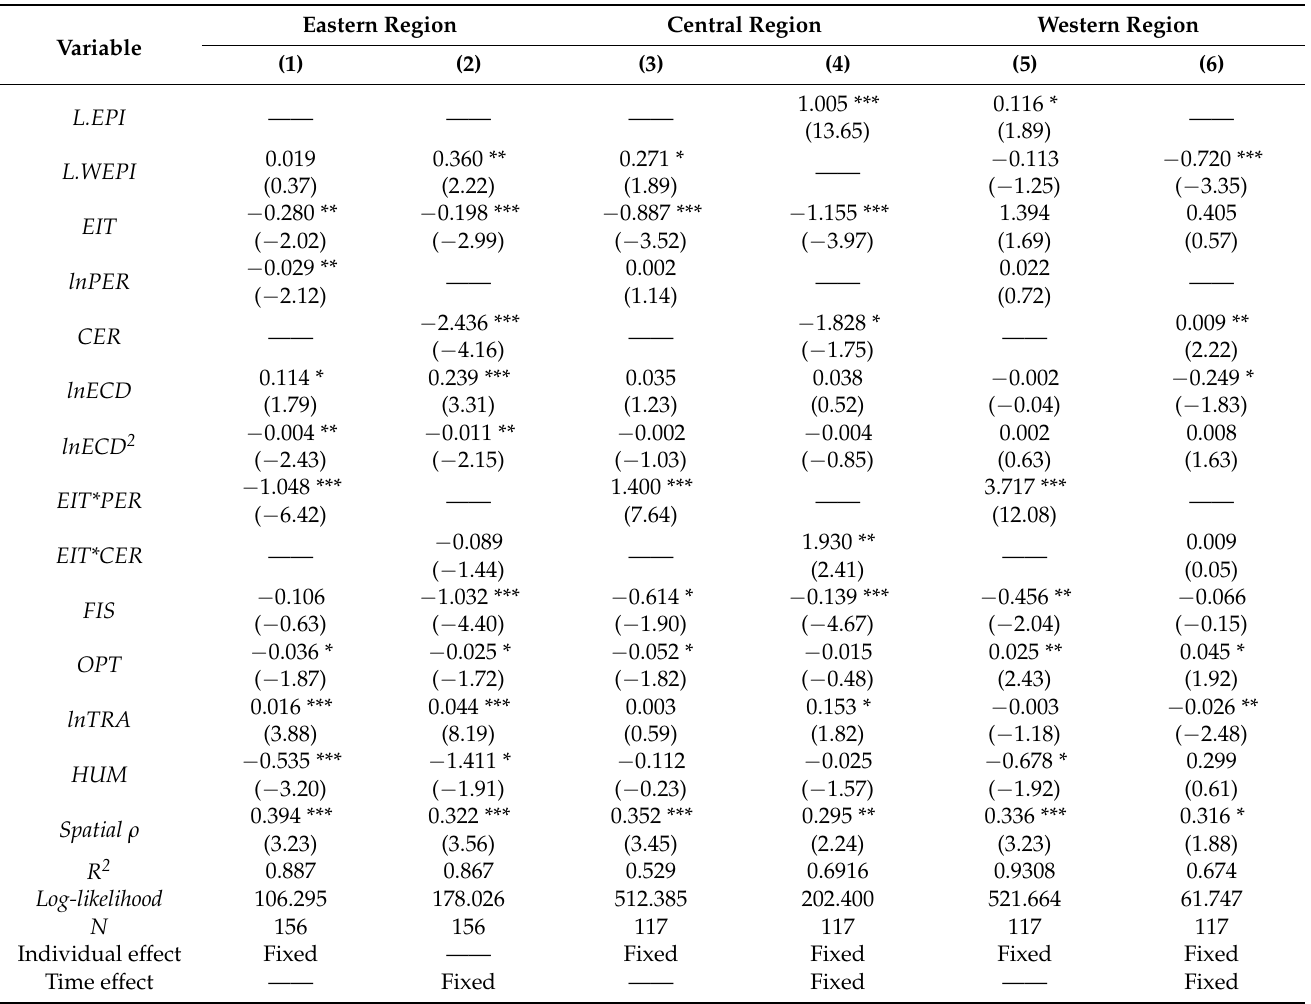
Table 6. Regression results of regional